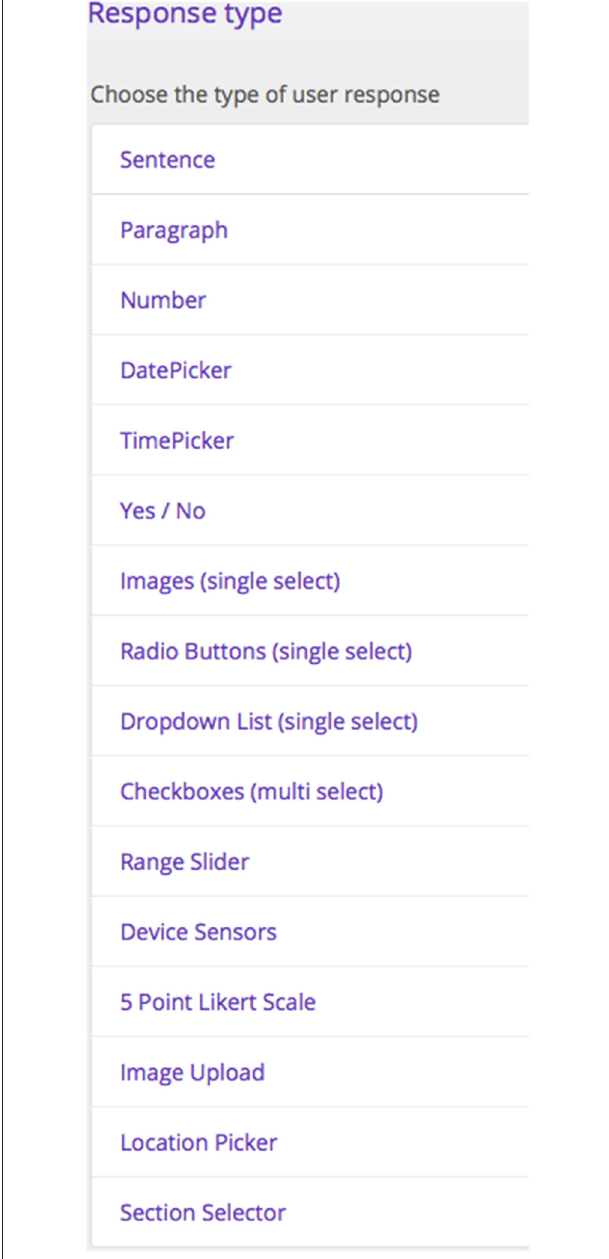
FIGURE 3 | Types of responses on